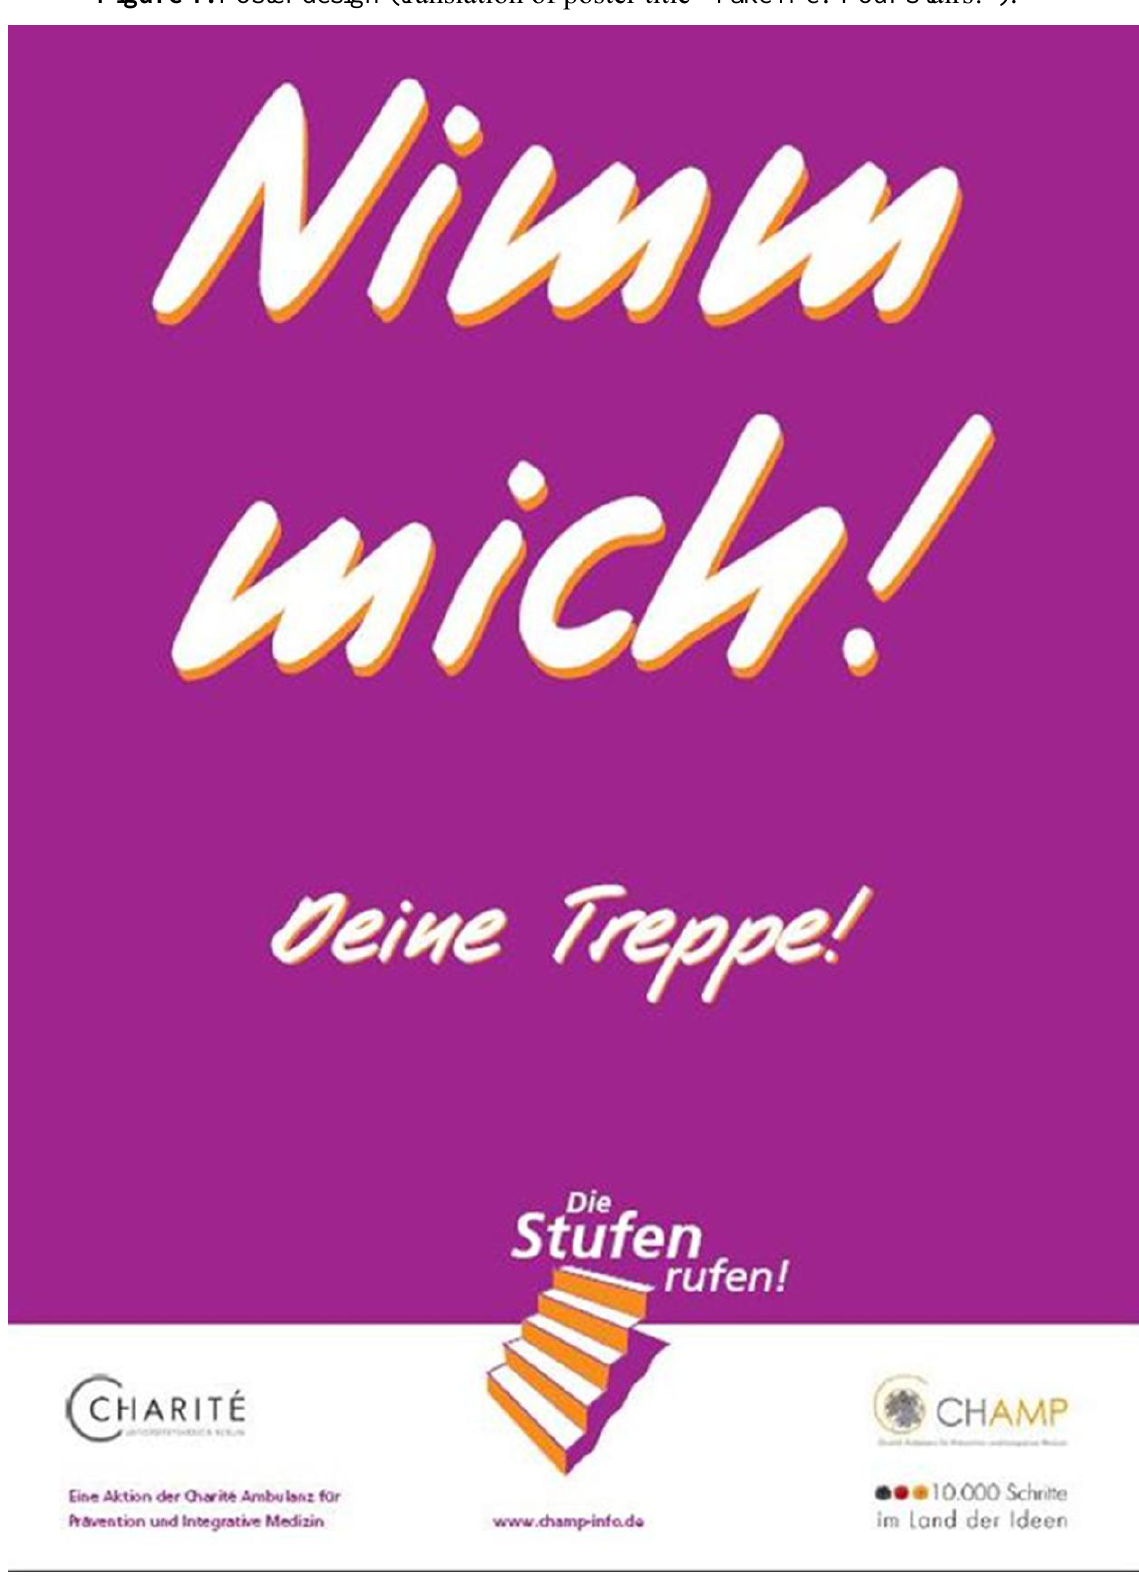
Figure 1. Poster design (translation of poster title ―Take Me! Your